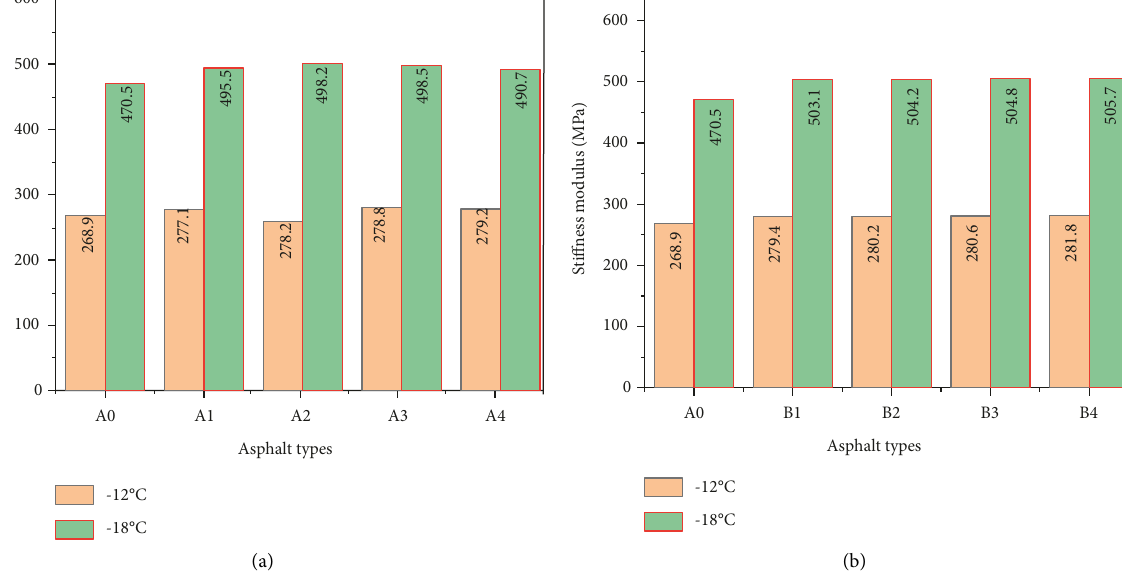
Figure 10: Modulus of stiffness of the GOMBA at different dosage levels. (a) Effects of different GO dosages on the stiffness modulus of bio-asphalt A and (b) effects of different GO dosages on the stiffness modulus of bio-asphalt